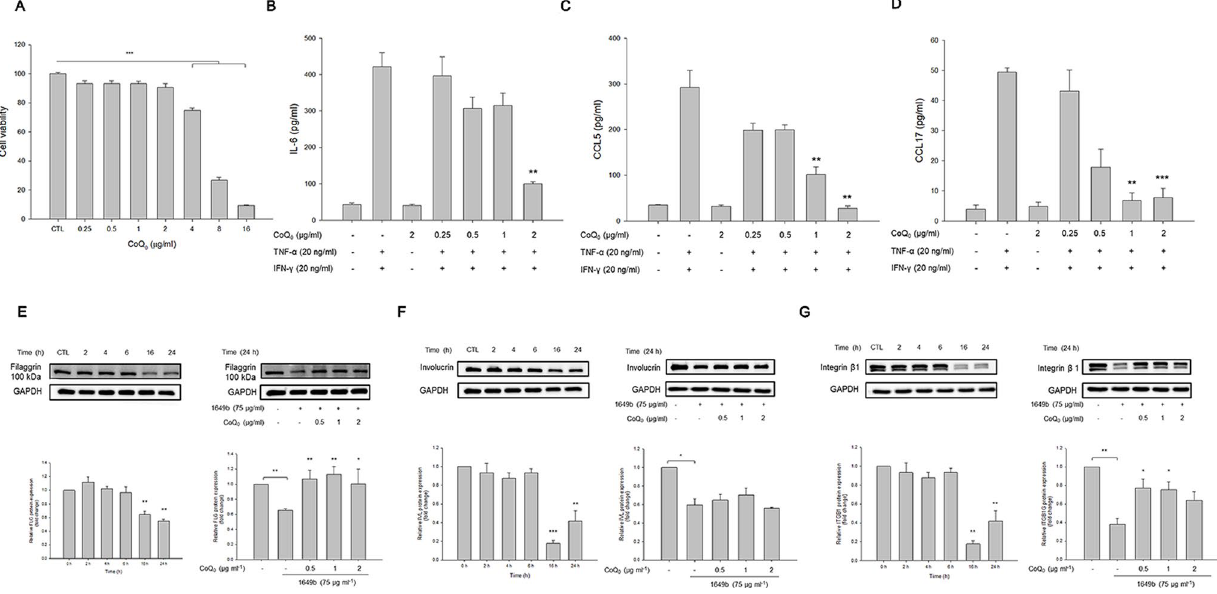
Frontiers in Pharmacology |